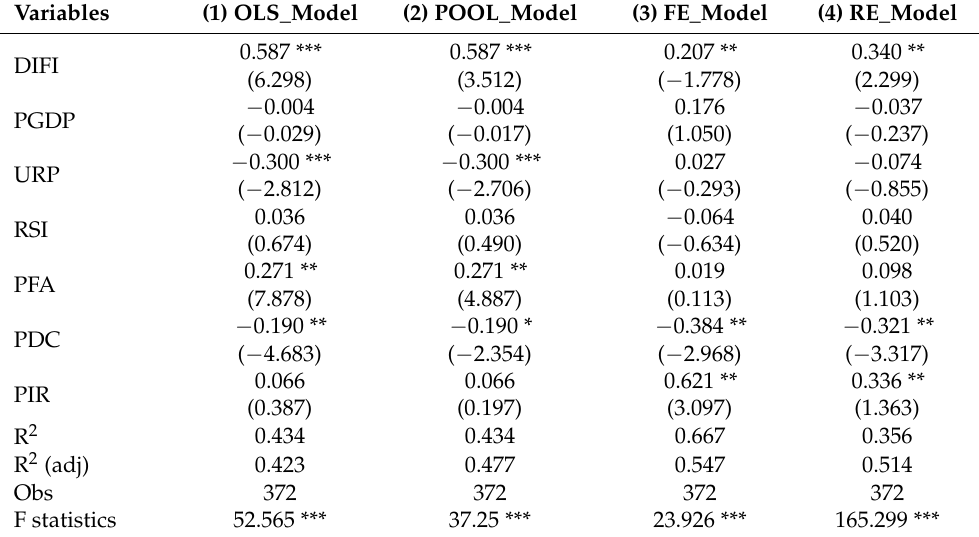
Table 4. Basic regression model